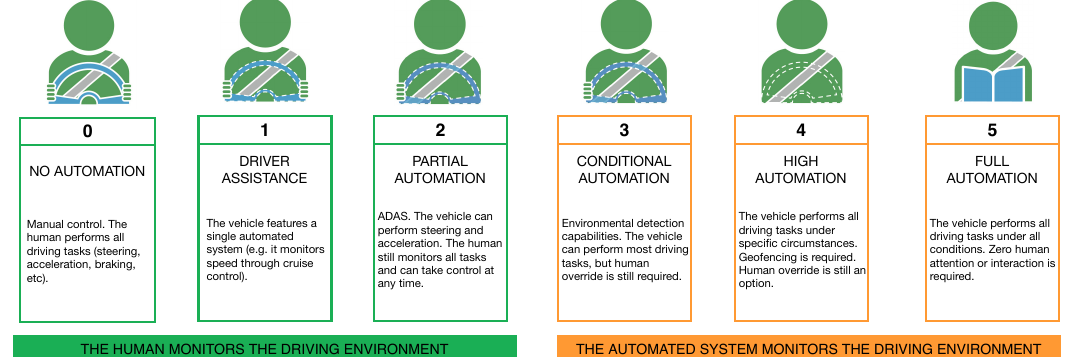
Figure 1. Society of Automotive Engineers (SAE) levels for driving